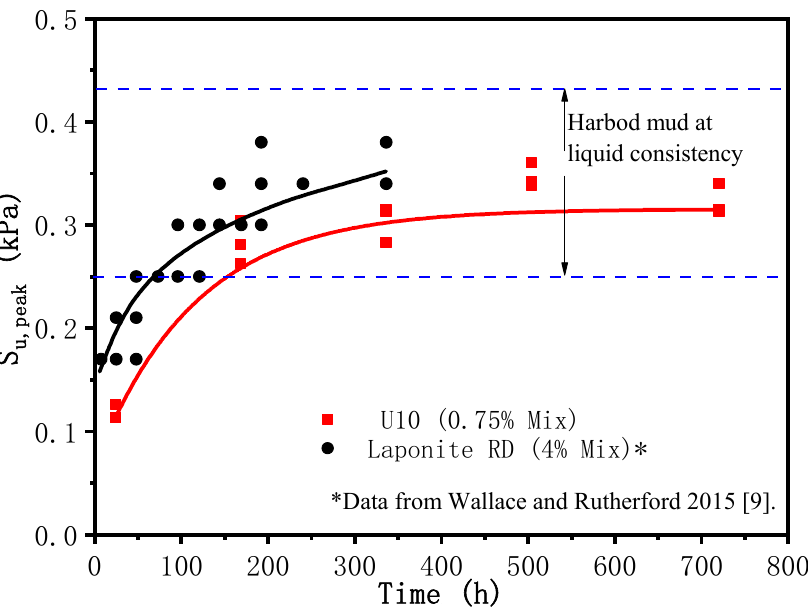
Figure 7. Peak undrained shear strength measured by the laboratory vane shear test for a 0.75% initial mixture.